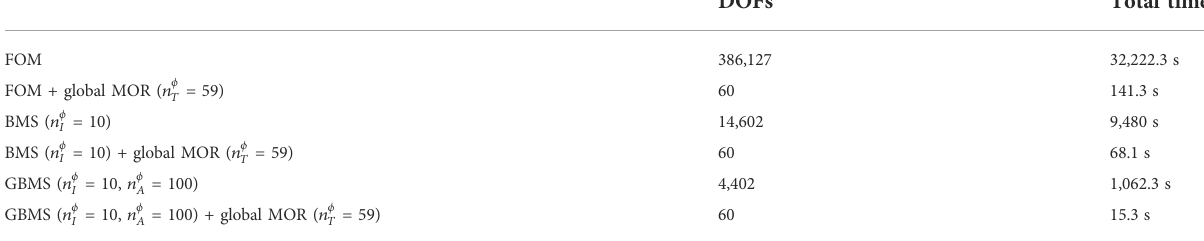
TABLE 3 Overview of FOM, BMS and GBMS UC based fi nite LRM plate model sizes for the clamped fi nite plate assembly of 5 × 5 UCs and total computational times required for the forced vibration